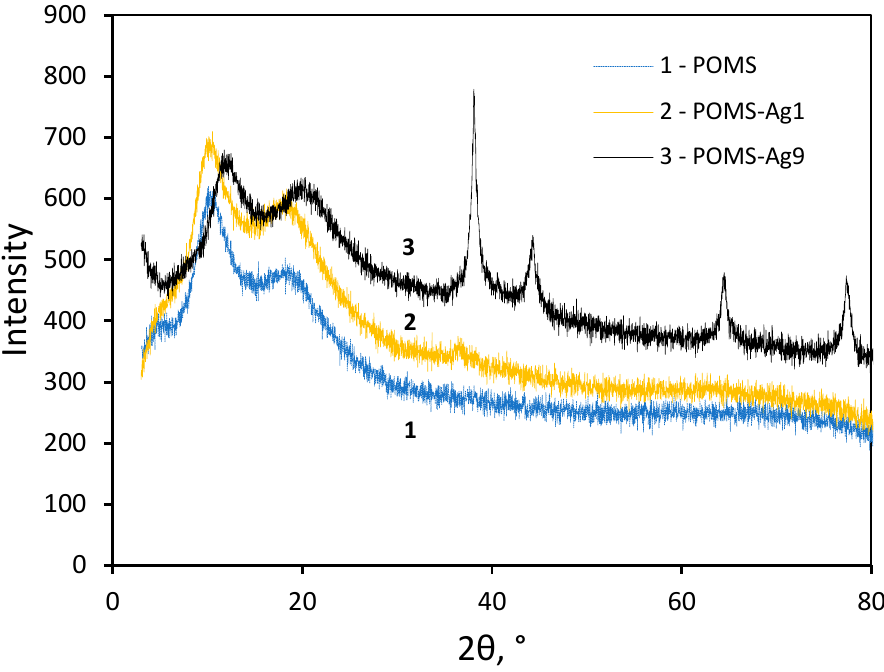
Figure 6. WAXD data: 1, POMS; 2, POMS-Ag1; 3, POMS-Ag9.